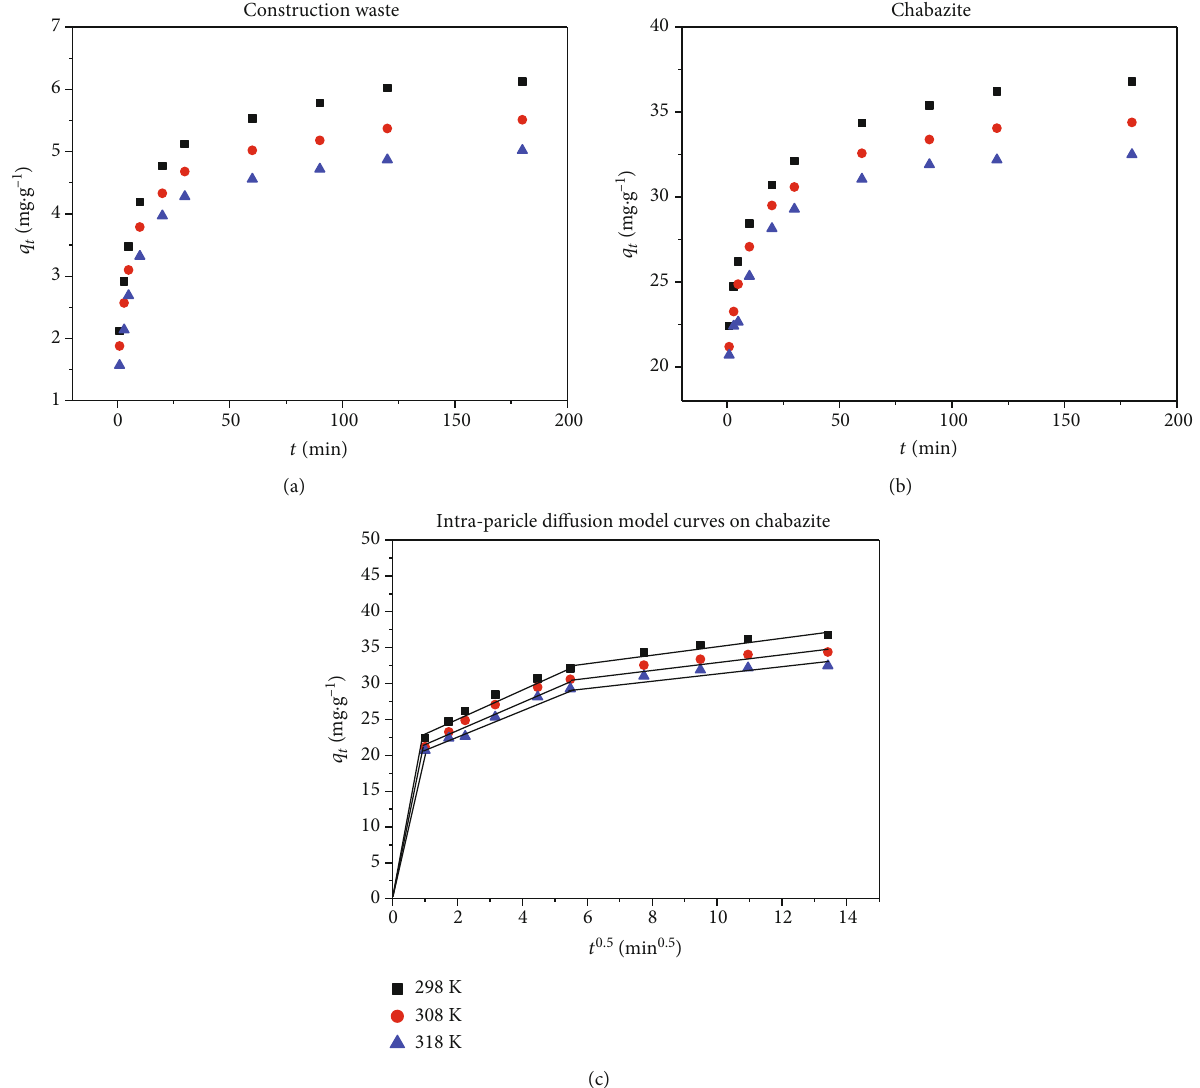
Figure 9: Adsorption kinetic curves of MB on (a) construction waste and (b) chabazite and (c) intraparticle di ff usion model curves on